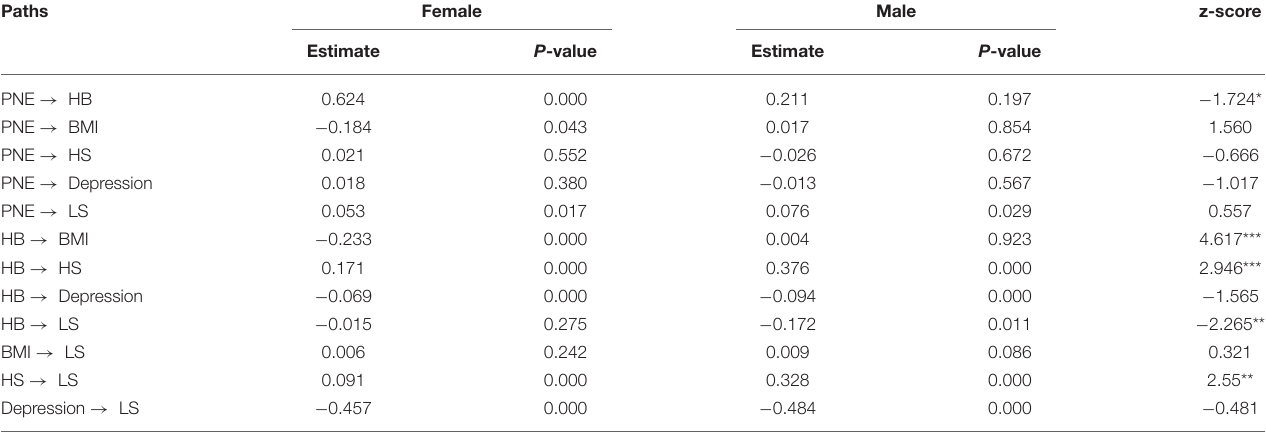
TABLE 6 | Results for moderating effects of gender.